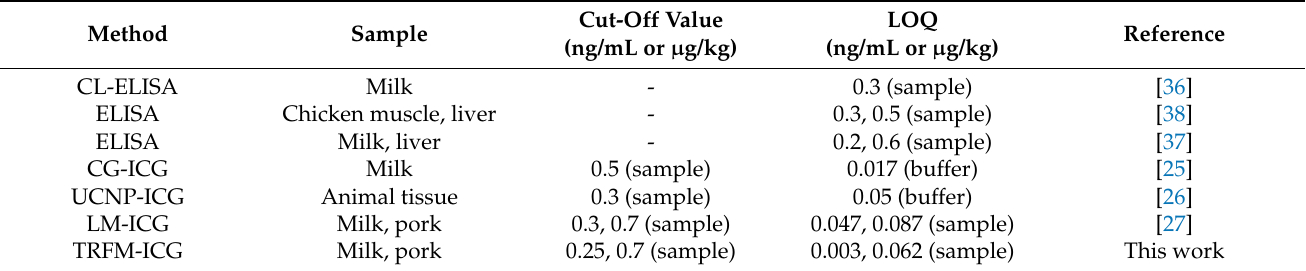
Table 3. Comparison of immunological methods for detecting DEX in animal-derived foods.